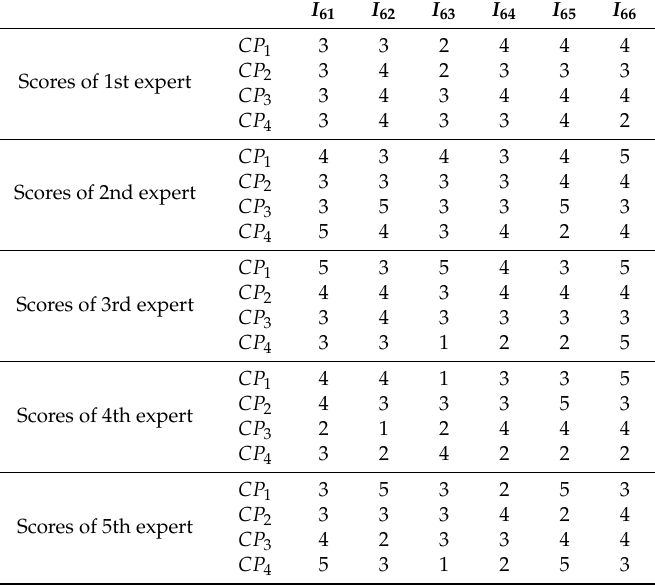
Table A15. Scores of the status level of the synergy process index.